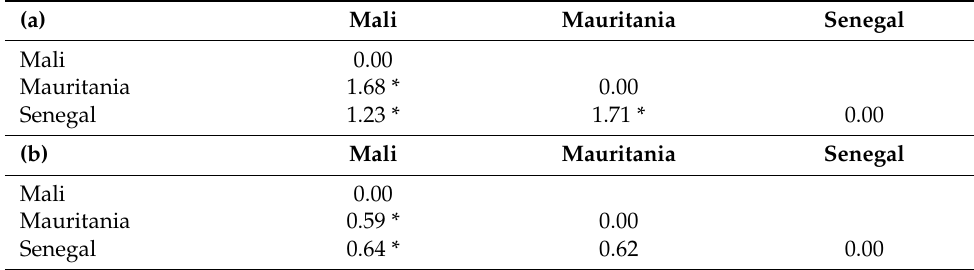
Figure 6. Factor map corresponding to Schistosoma haematobium eggs shed by humans from Mali, Mauritania and Senegal: ( a ) all measurements analyzed; ( b ) spine measurements analyzed. Each group is represented by its perimeter. Dotted line: Mali; solid line: Mauritania; dashed line: Senegal. Circle: Mali centroid; square: Mauritania centroid; triangle: Senegal centroid. Mahalanobis distances between the three S. haematobium populations (Mali, Mauritania and Senegal) (Table 5) show statistically significant differences between Mali, Mauritania and Mali and Senegal when only spine measurements are considered. Table 5. Mahalanobis distances between the three S. haematobium populations (Mali, Mauritania and Senegal) for the two discriminant analyses performed: ( a ) all measurements (17) and ( b ) spine measurements (4).